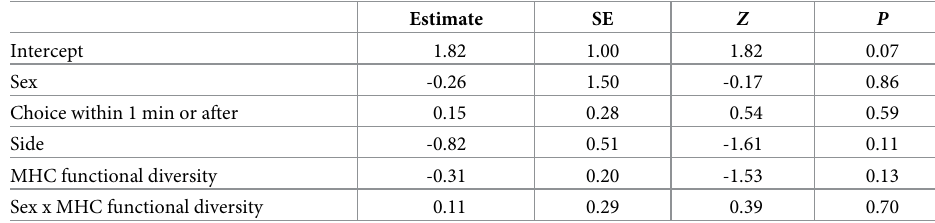
Table 2. Model for bird choice in relation to: The number of MHC-I functional alleles of a potential partner (as a dichotomous variable: Greater functional diversity (yes) vs. lower functional diversity).